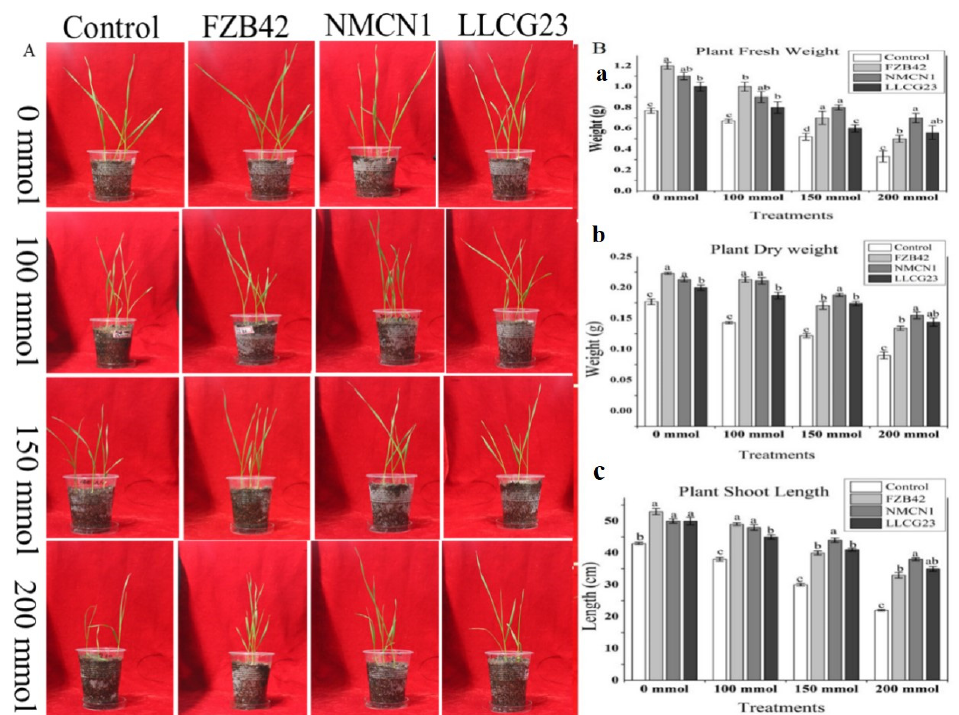
Figure 7. Effect of Bacillus spp. strains (FZB42, NMCN1 and LLCG23) on wheat plants grown under different salt conditions (0 mmol–200 mmol). ( A ) Visual representation showing the effect of the selected strains on wheat plants under saline conditions; ( B ) graphical detail of different plant parameters, i.e., ( a ) fresh weight of wheat plants inoculated with Bacillus strains grown in different salt stress conditions; ( b ) plants dry weight; ( c ) plant total shoot length. Standard deviations of mean ( n = 3) were used to indicate error bars on the columns. The small letters were used to show significant difference among the treatments calculated through Tukey’s HSD test at p ≤ 0.05. The experiment was repeated thrice with three replicates for each